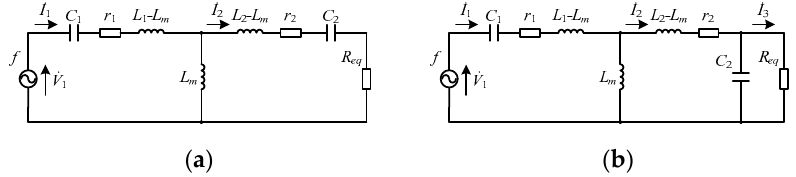
Figure 4. Equivalent circuits for designing the IPT systems: ( a ) is the SS compensation method, and ( b ) is the SP compensation method.